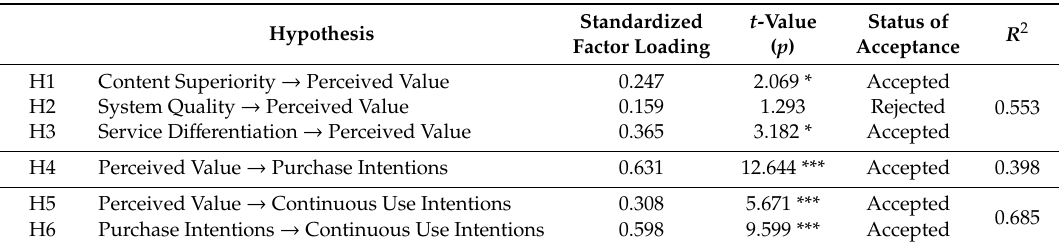
Table 5. Results of hypothesis testing.